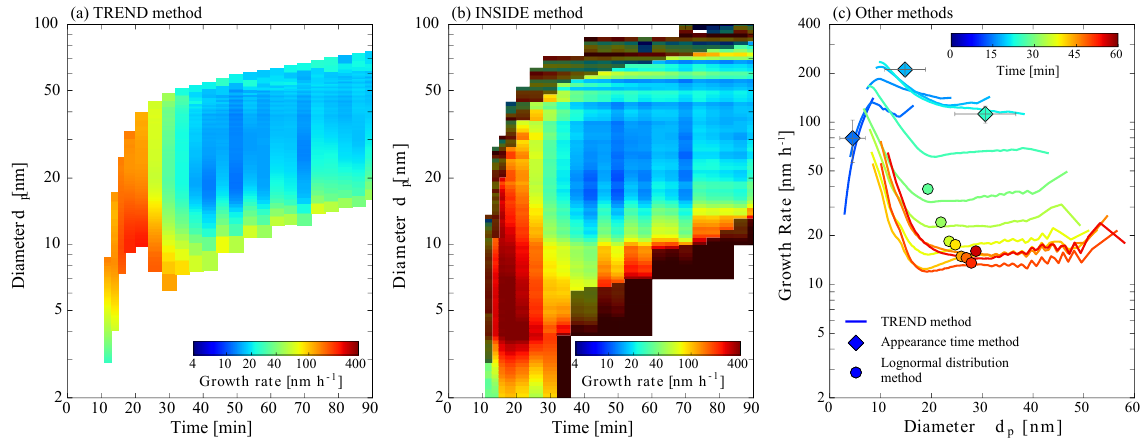
Figure 5. Growth rate analysis of the β -caryophyllene ozonolysis experiment. Panel (a) shows the results of the TREND method, while panel (b) shows the results of the INSIDE method. The color coding represents the growth rates in nmh − 1 . For the INSIDE method, regions with low counting statistics are greyed out. Panel (c) shows a comparison of the growth rate analysis results obtained from the TREND method (continuous lines) with results from two other methods, namely the appearance time method and the lognormal distribution method (discrete diamonds and circles,